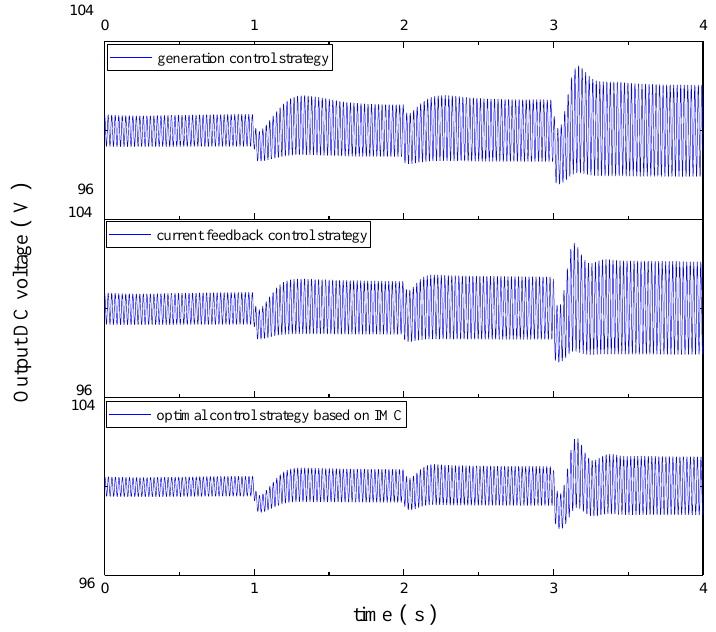
Figure 9. Comparison of load voltage of three control strategies.